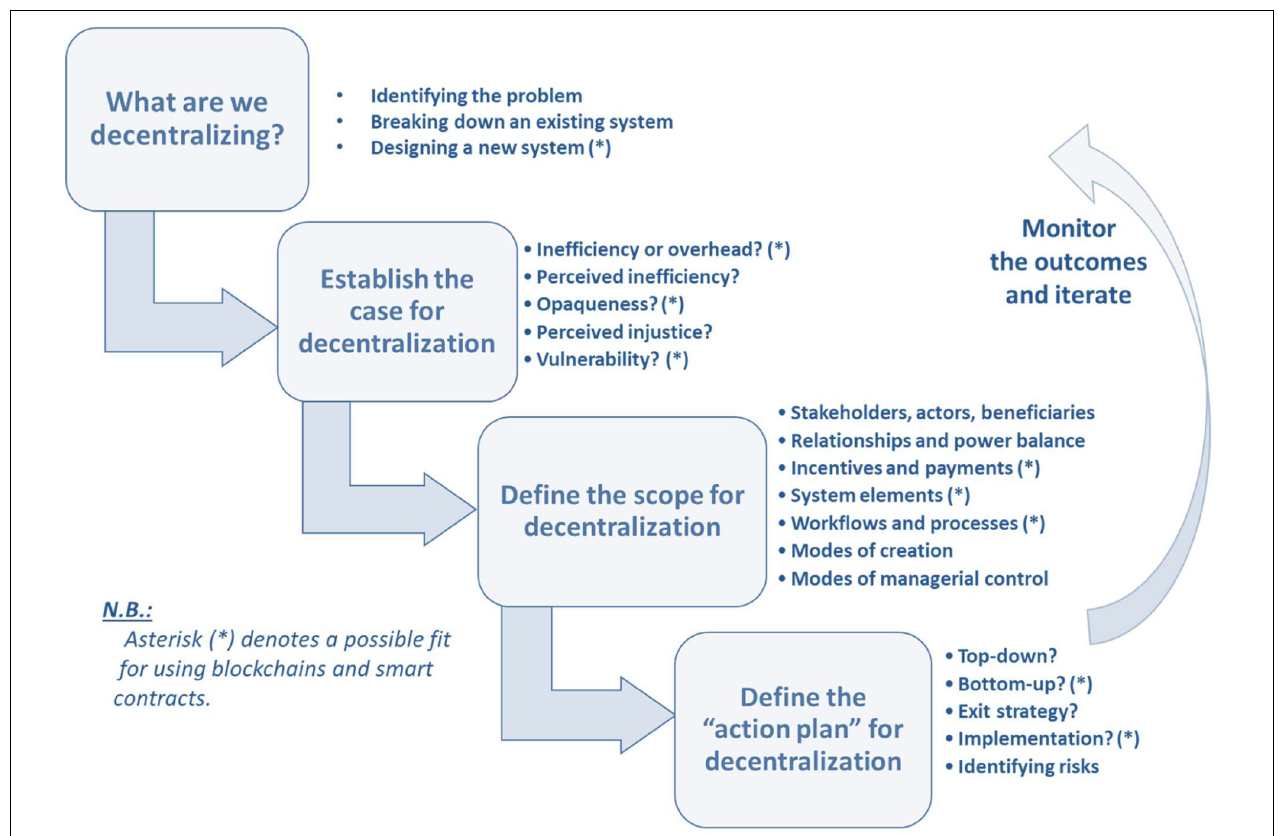
FIGURE 1 | Framework for decentralizing a system, possibly using